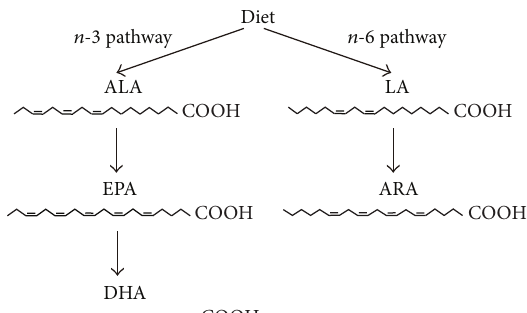
Figure 1: Synthesis of n -3 and n -6 PUFAs. DHA and ARA can be synthesized from ALA and LA,